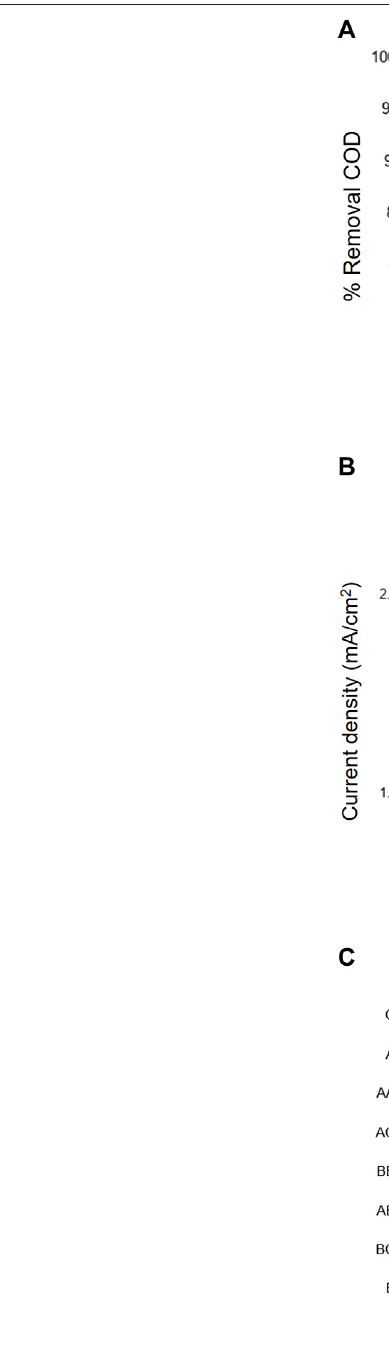
Frontiers in Environmental Science |